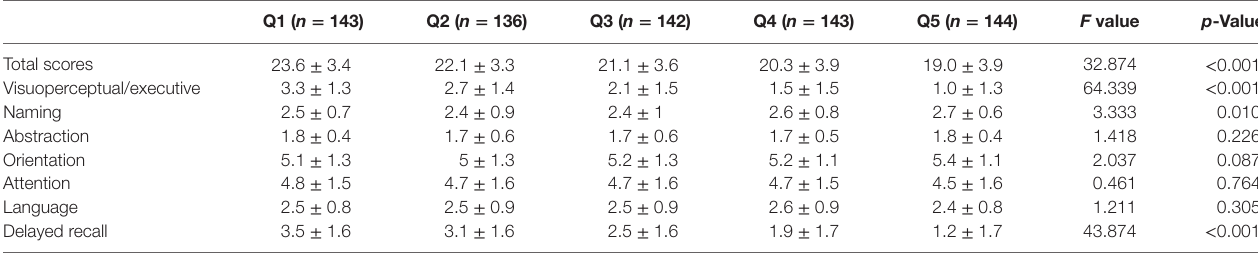
TaBle 3 | The relationship of MoCA score in each cognitive domain at 3 months and CV of systolic blood pressure within 7 days of stroke onset.